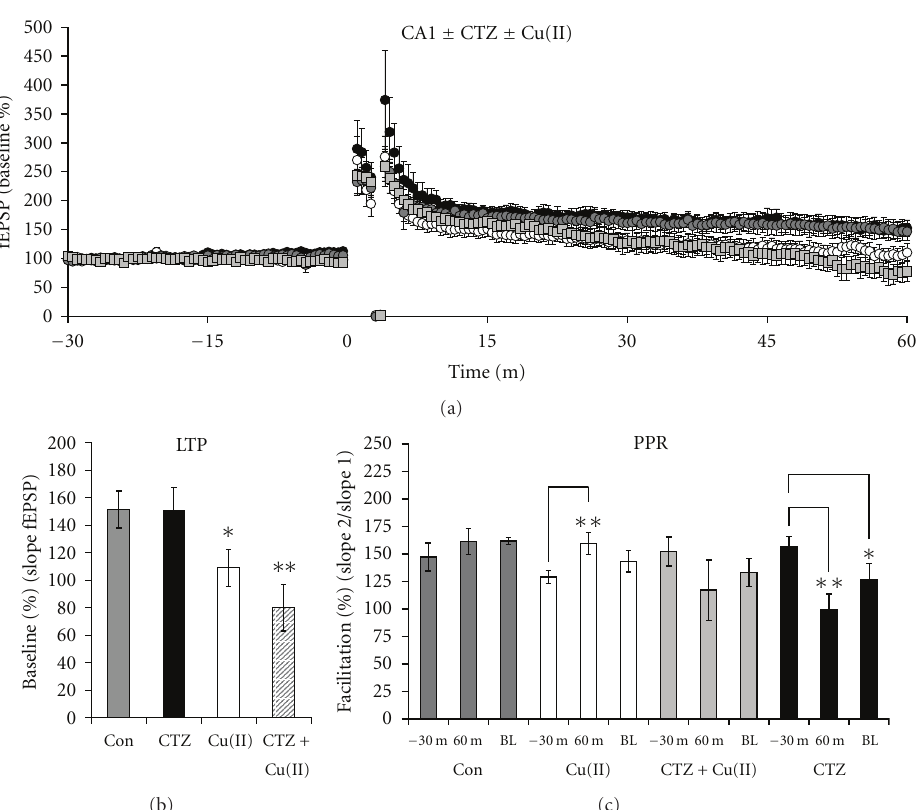
Figure 7: CTZ modulated the e ff ect of copper on synaptic plasticity in the CA1 region. (a) Slices treated with CTZ (black circles) and control slices (gray circles) exhibited identical LTP, but LTP was inhibited by copper (open circles) and by copper combined with CTZ (gray squares). (b) The level of LTP was 151 . 5 ± 13 . 4% in control slices (gray bar) ( n = 8) and 151 . 0 ± 16 . 7% in CTZ-treated slices (black bar) ( n = 8). Copper reduced the LTP to 109 . 0 ± 13 . 3% (white bar), and LTP was further reduced to 80 . 1 ± 17 . 0% in slices treated with copper and CTZ (striped bar) ( n = 8). (c) There was no significant di ff erence among the PPRs at 30 minutes prior to the tetanus across groups. At 60 minutes after tetanus, there was no change in the PPR in the control group, a significant enhancement in the PPR in the copper group ( P = 0 . 028, n = 7), no significant change in the PPR in the CTZ + copper group, and a significant decrease in the PPR in the CTZ group ( P = 0 . 006, n = 7). The baseline (BL) PPRs measured after 90 minutes without a tetanus was decreased from 152 . 2 ± 13 . 1% at 30 minutes prior to the tetanus to 133 . 3 ± 12 . 5% in slices treated with CTZ ( P = 0 . 018, n = 7). The BL PPRs did not vary among the other